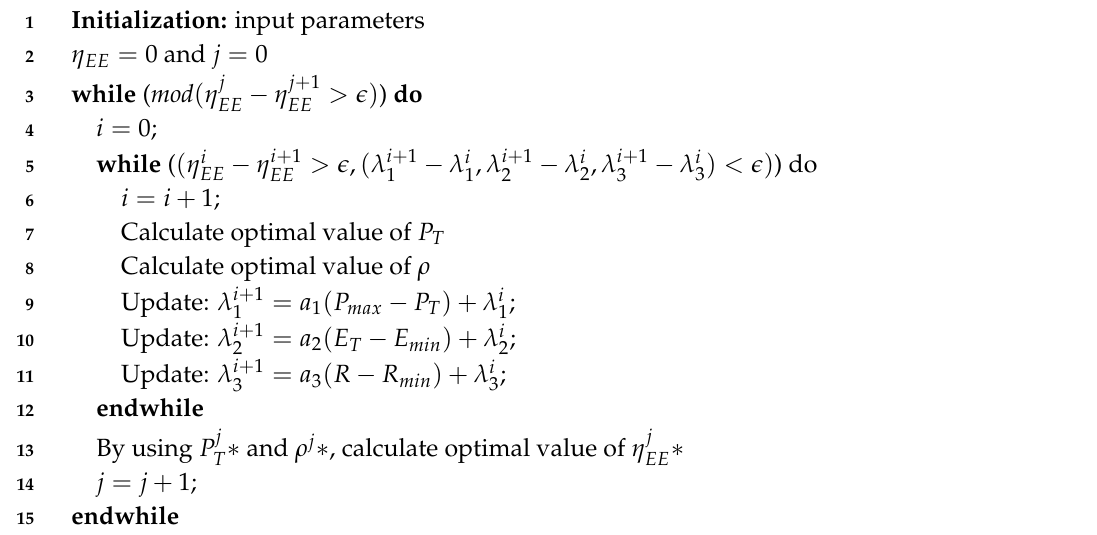
Algorithm 2: Proposed iterative power splitting